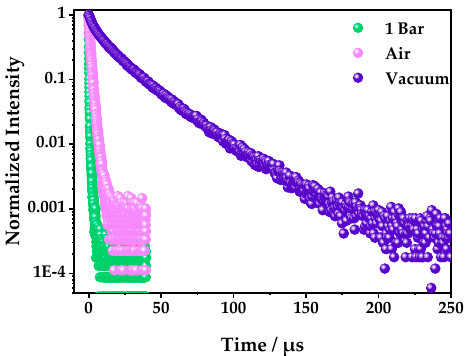
Figure 6. The photoluminescence decay curves of 1 in 1 bar O 2 , air, and a vacuum—excited by a 375 nm variable-pulsed laser (VPL) and detected at 542 nm.